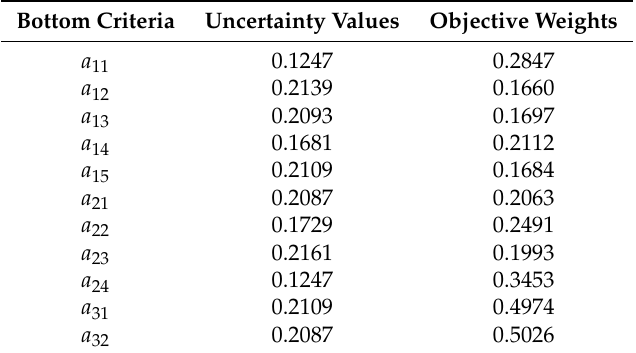
Table 4. Objective weights of bottom criteria.